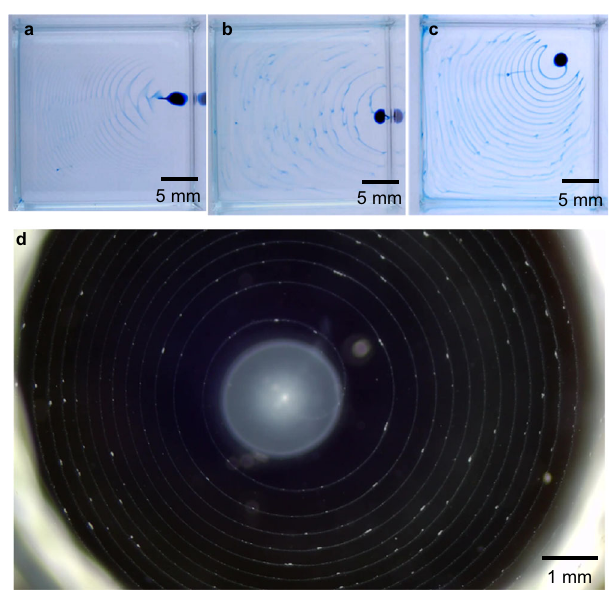
Fig.9|Differenttypesofpatterns.a mackerel-cloud, b halfcircles,and c crescent patterns formed by placing the DEX-MB-CaCl 2 droplet near the wall, next to the wall,and nearthecornerinthecuvette,respectively. d Formationof PEI-PEGspiral patterns by adding PEI (0.5%)-DEX (16%)-CaCl 2 (50mM) droplet to the PEG-SDBS (2.5mM) bulk solution. The photo was taken under white light